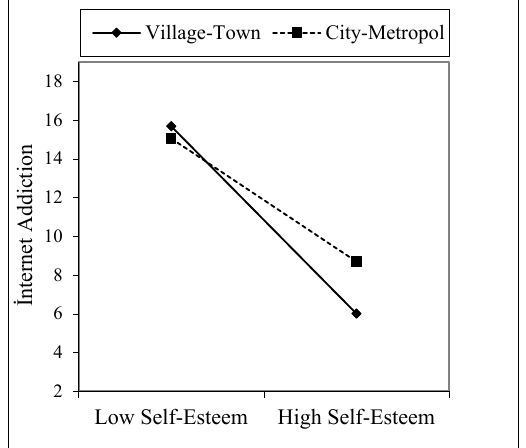
Figure 2. Interaction effect of self-esteem and gender on internet addiction.